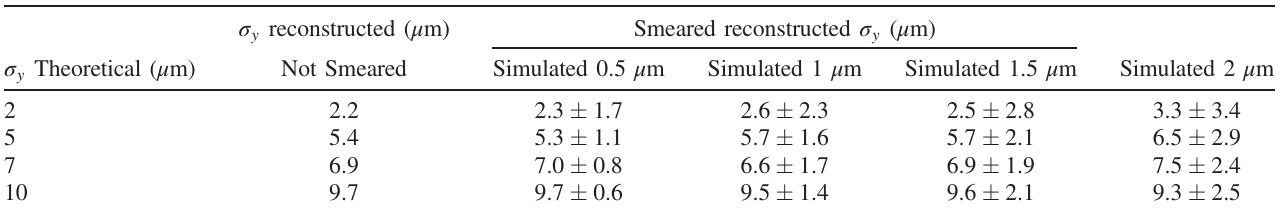
TABLE III. Results of simulations of small vertical beam size reconstruction: rotating SRI reconstruction without smearing compared with results produced by smearing the rotated beam sizes of 0.5, 1, 1.5, and 2 μ m with the respective error. σ μ y reconstructed (